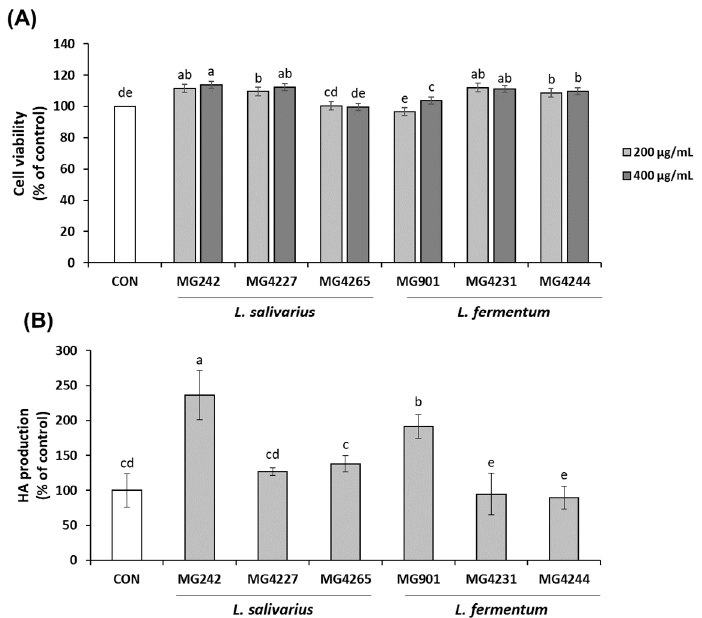
Figure 1. Effect of CFS derived from probiotic bacterial strains on ( A ) cell viability, and ( B ) hyaluronic acid (HA) production in HaCaT keratinocytes. Data are represented as mean ± SD ( n = 3). Statistical significance is indicated by different letters over the column ( p < 0.05).